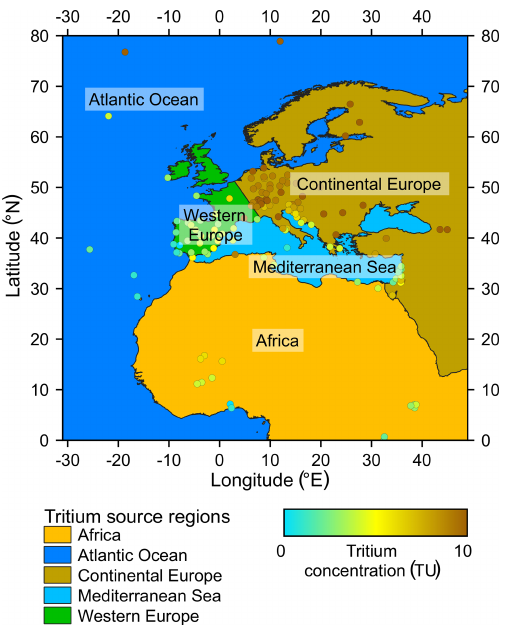
Figure 2. Map of the GNIP stations that provide tritium concentra- tion in precipitation and of the derived tritium source regions. GNIP stations are color coded by the mean of the annual averages of the tritium concentration over the period from 2000 to 2016 (the data coverage of individual stations varies). For more details on the dif- ferentiation of the five tritium source regions, readers are referred to the